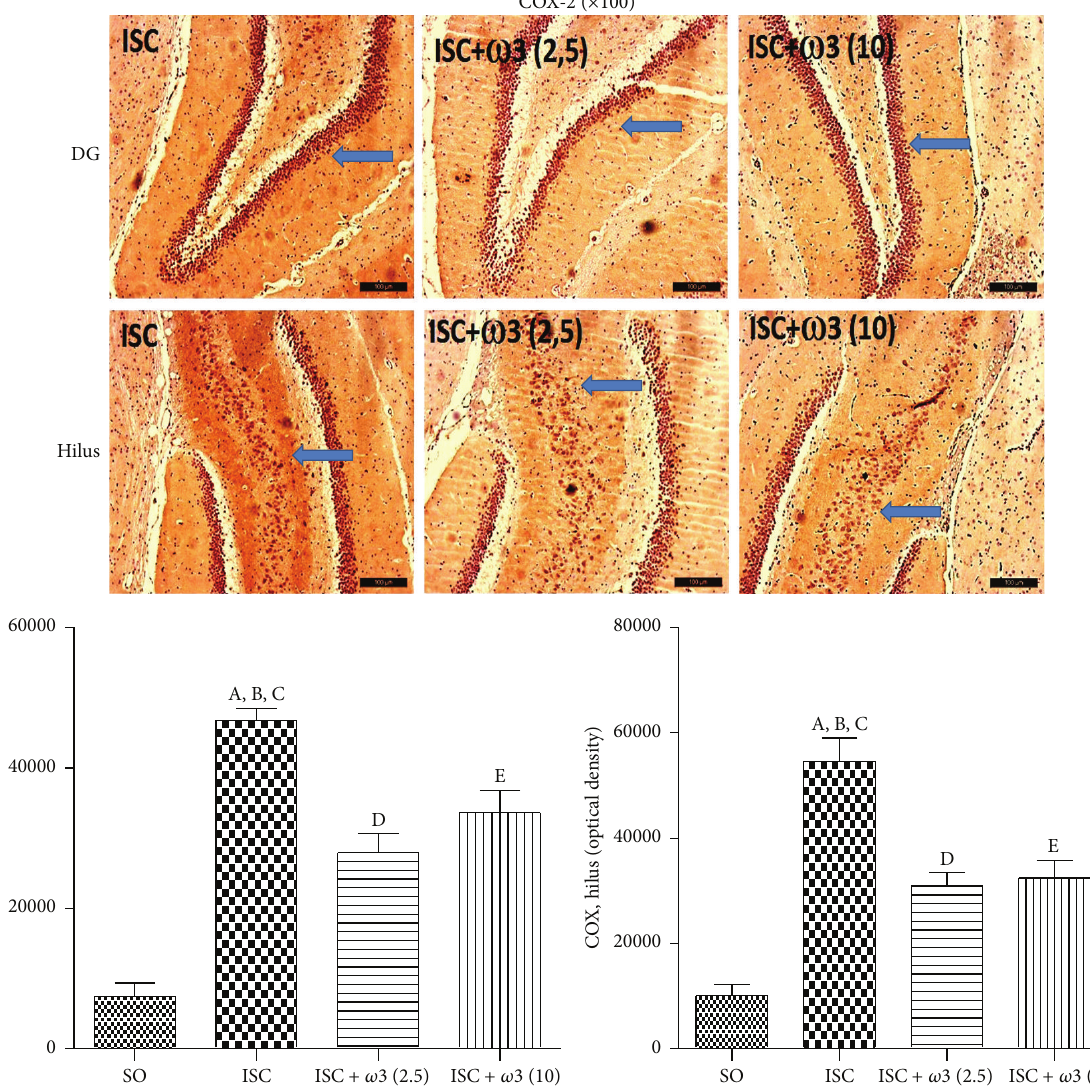
Figure 7: 𝜔 3 treatments of ischemic animals (3 animals per group) reduced the immunostaining for COX-2, mainly in the dentate gyrus (DG) and hilus. Representative photomicrographs and quantitative measurements performed with the Image J software, from 3 to 5 fields. The groups are untreated ischemic (ISC) and ischemic after treatments with 𝜔 3 (2.5 and 10mg/kg, 7 days). DG: (A) versus SO, q = 14.88 ∗∗∗ ; (B) versus ISC + 𝜔 3 (2.5), q = 7.135 ∗∗∗ ; (C) versus ISC + 𝜔 3 (10), q = 4.979 ∗∗ . Hilus: (A) versus SO, q = 13.95 ∗∗∗ ; (B) versus ISC + 𝜔 3 (2.5), q = 7.418 ∗∗∗ ; (C) versus ISC + 𝜔 3 (10), q = 6.943 ∗∗∗ ; (D) versus SO, q = 6.527 ∗∗∗ ; (E) versus SO, q = 7.003 ∗∗∗ (one-way ANOVA and Newman-Keuls test as the post hoc